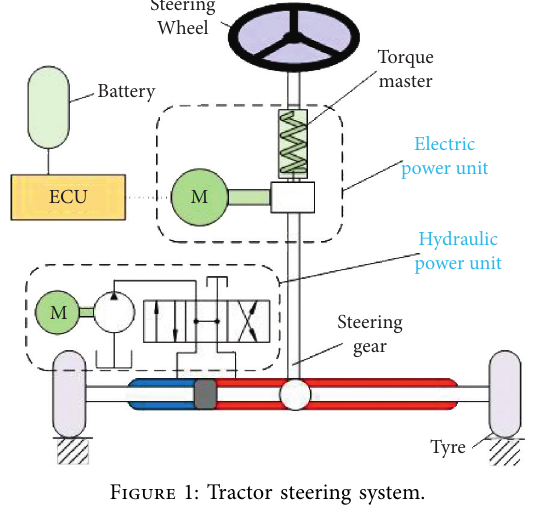
Figure 1: Tractor steering